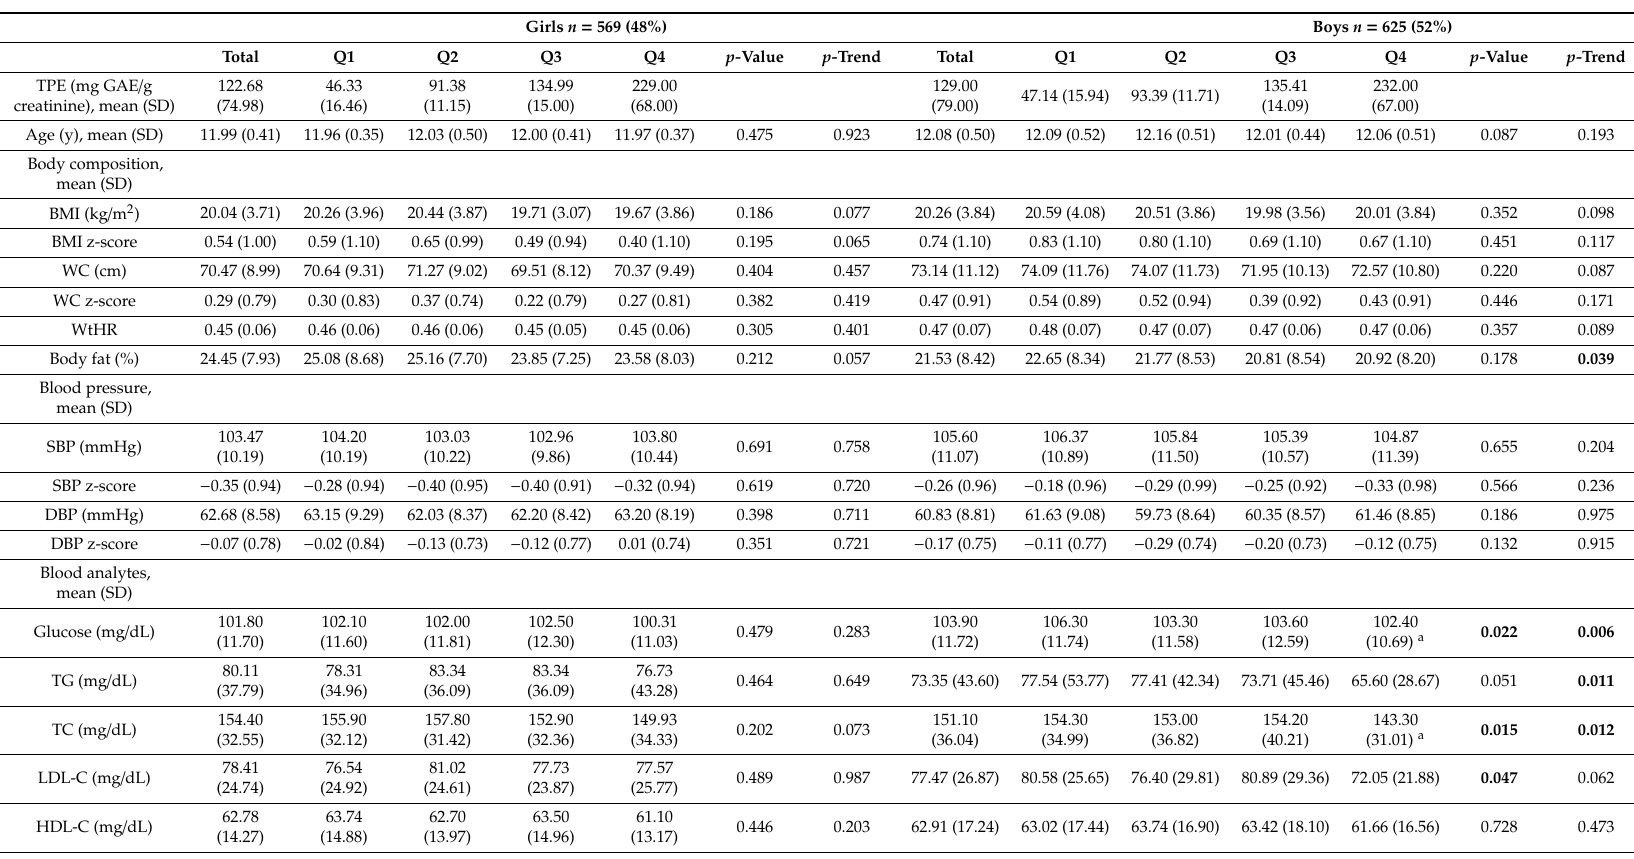
Table A1. Baseline characteristics of the study population, according to gender and quartiles of TPE ( n =